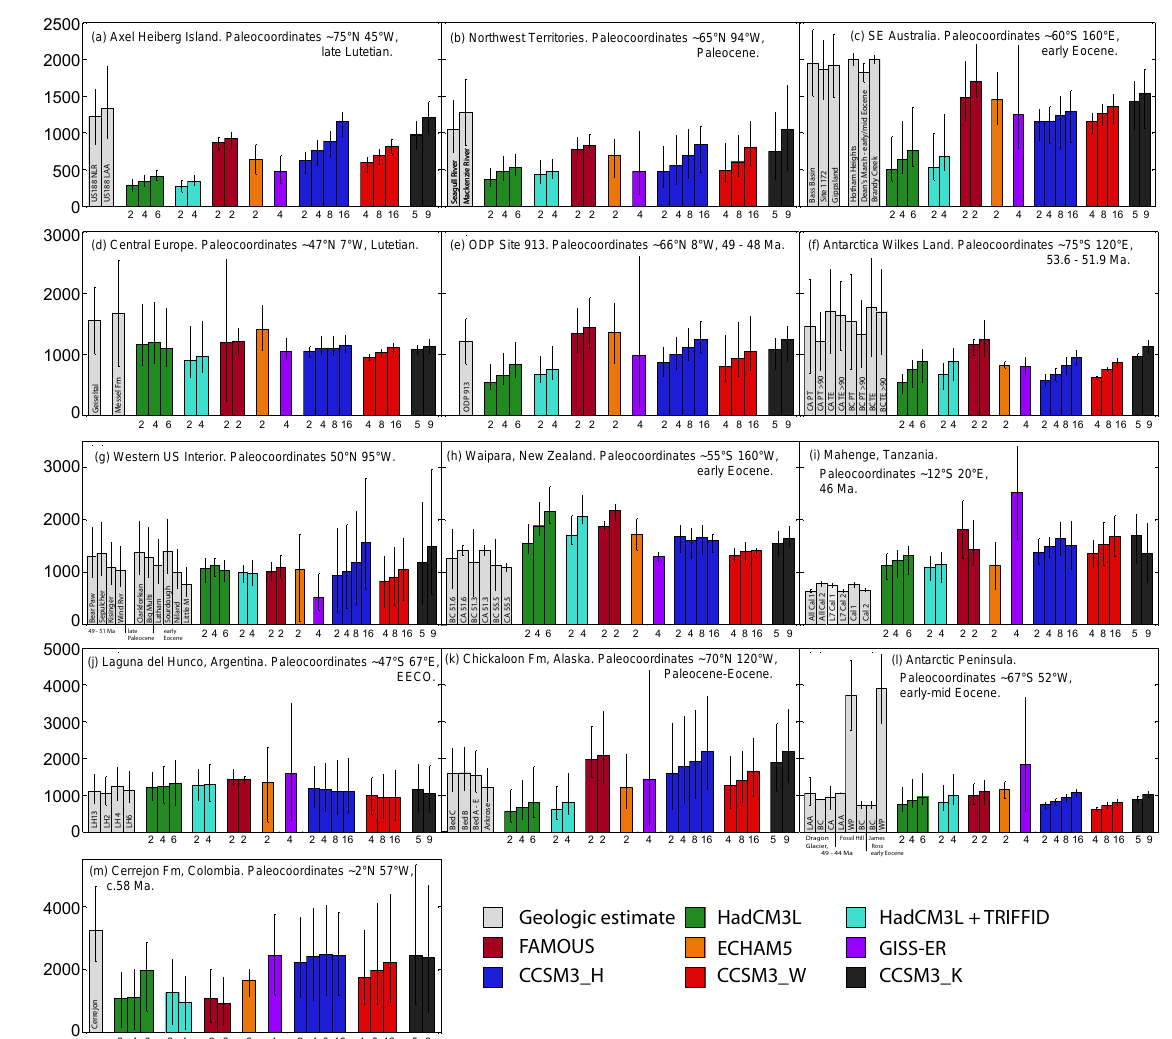
Figure 10. Proxy–model comparisons for mean annual precipitation (MAP) for the EoMIP ensemble: (a) Axel Heiberg Island, data from Greenwood et al. (2010); (b) Northwest Territories, data from Greenwood et al. (2010); (c) southeastern Australia and Tasmania, data from Greenwood et al. (2005) and Contreras et al. (2014); (d) central Europe, data from Mosbrugger et al. (2005) and Grein et al. (2011); (e) Ocean Drilling Program (ODP) Site 913, data from Eldrett et al. (2009); (f) Wilkes Land, data from Pross et al. (2012); (g) western US interior, data from Wilf et al. (1998) and Wilf (2000); (h) Waipara, New Zealand, data from Pancost et al. (2013); (i) Mahenge, Tanzania, data from Jacobs and Herendeen (2004) and Kaiser et al. (2006); (j) Argentina, data from Wilf et al. (2005); ( k ) Chickaloon Formation, Alaska, data from Sunderlin et al. (2011, 2014); (l) Antarctic Peninsula, data from Hunt and Poole (2003) and Poole et al. (2005); (m) Cerrejon Formation, data from Wing et al. (2009). Error bars show the mean with range based on nine model grid cells closest to given paleocoordinates. Full details are given in the Supplement, Table